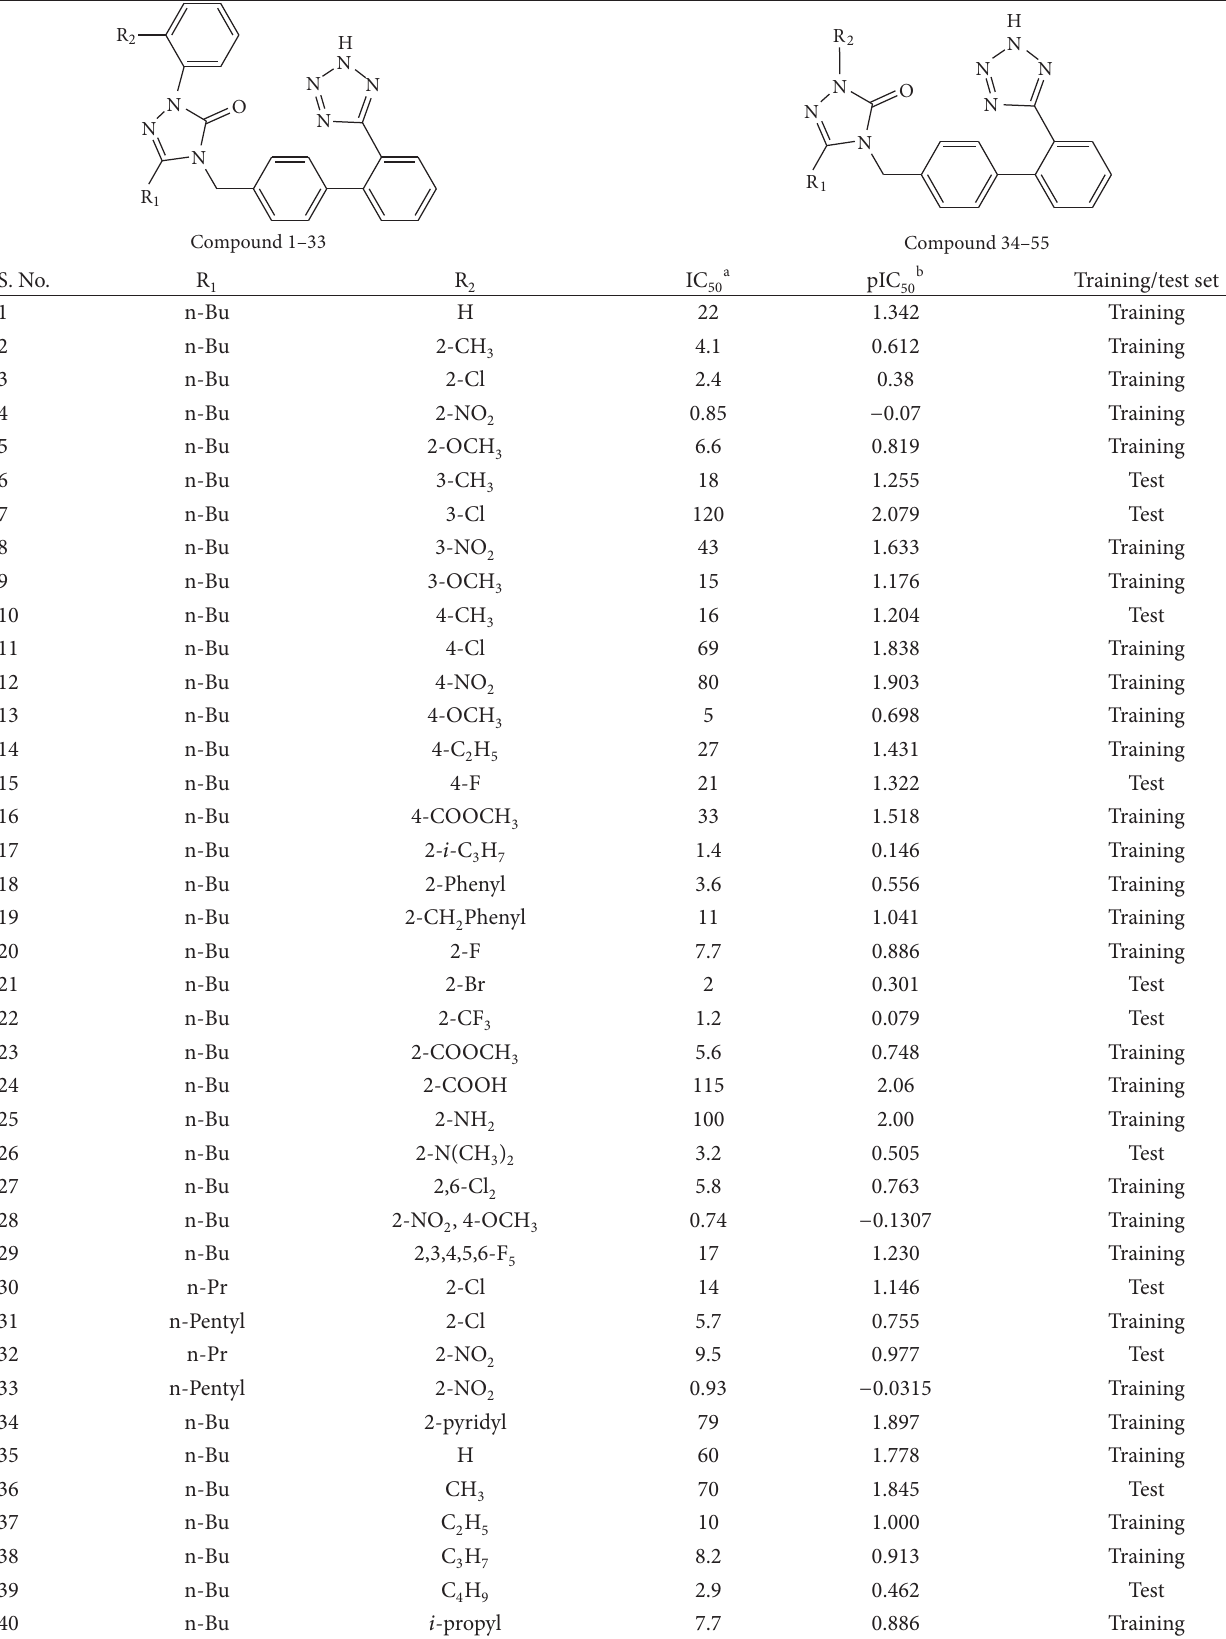
T 1: e structures of triazolinone aryl and nonaryl derivatives with their